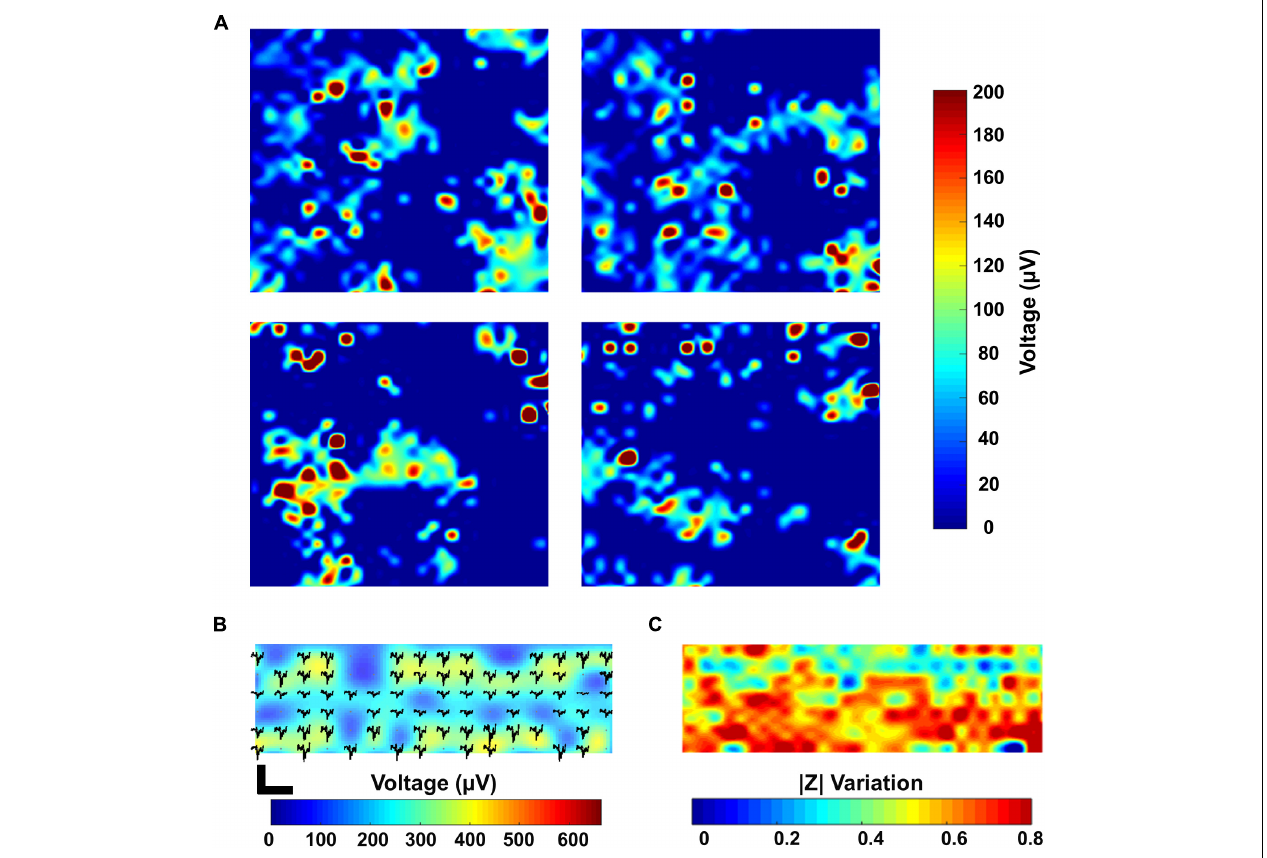
FIGURE 6 | Combined electrical recording and impedance imaging. (A) Spike maps showing the maximum amplitude recorded in four active areas (active areas 1–4) on a 15 DIV PHN neuronal culture. Each individual map corresponds to a 500 × 500 µ m 2 active area on the chip. The map includes the measurement over all the four electrodes present in a pixel for all the 1024 pixels. This results in a total of 4096 electrodes measured in groups of 1024 (one electrode measurement per pixel). (B,C) Spike map and electrical impedance image of a 43 DIV PHN neuronal culture zoomed in an area corresponding to a 250 × 500 µ m 2 surface and 512